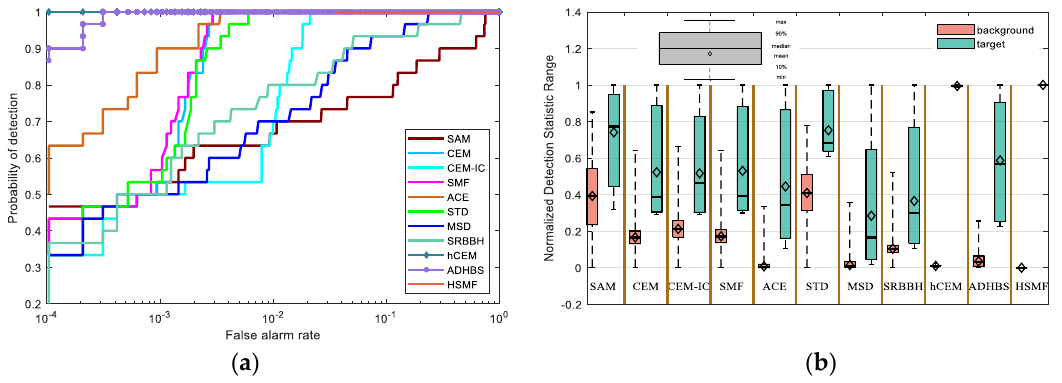
Figure 8. ( a ) ROC curves of different detectors on the Urban data. ( b ) The separability map of all detectors for the Urban data. Table 3. AUC values and AUC values at lower FAR of all detectors for the Urban data.